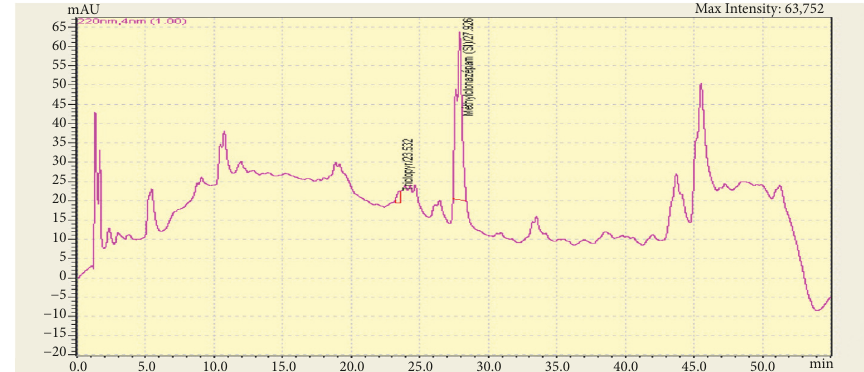
Figure 1: Chromatogram showing a triclopyr peak at 23rd minute, with methylclonazepam as internal